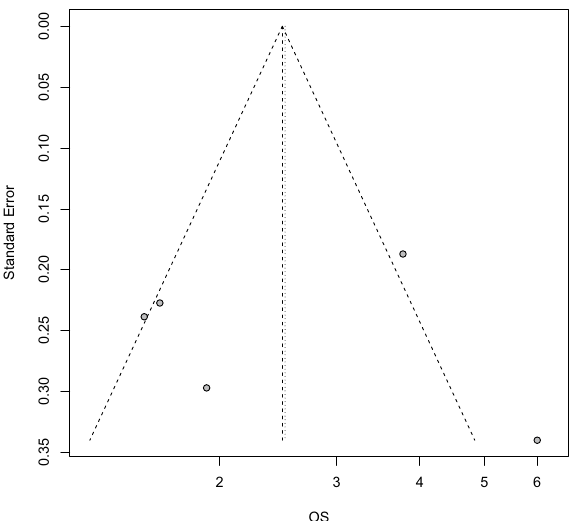
Figure 5. Funnel plot for the association of LOX expression with